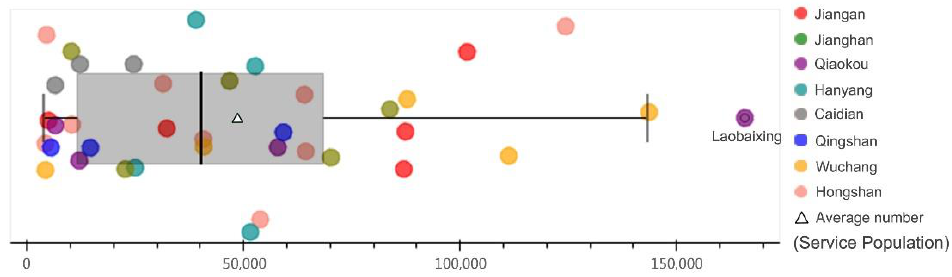
Figure 14. Service population of the designated pharmacies (aggregation unit: district).